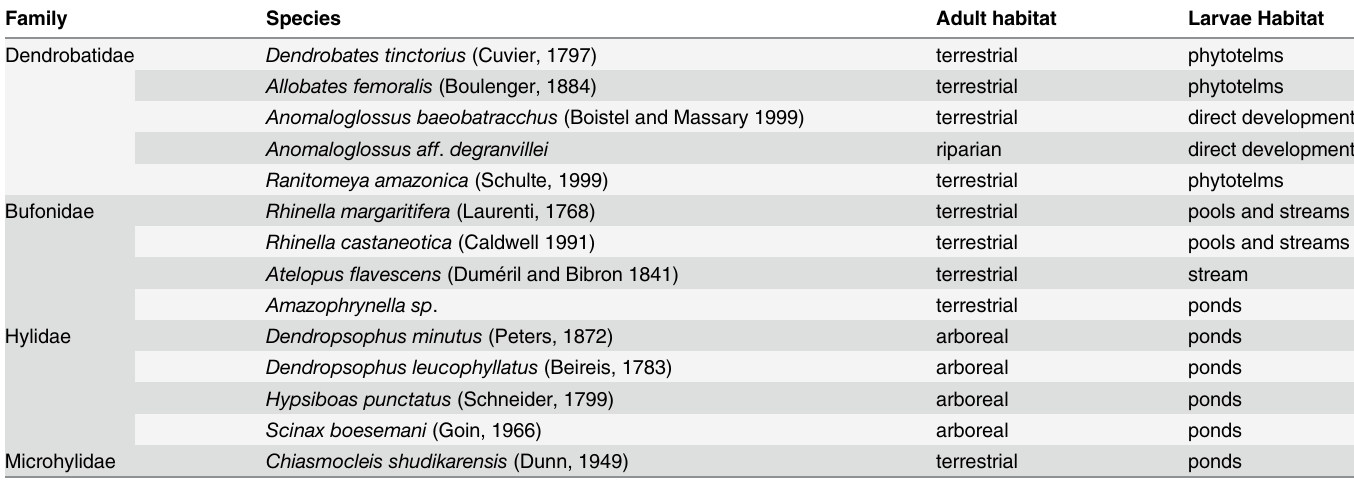
Table 2. Description of the species sampled in 2011 –